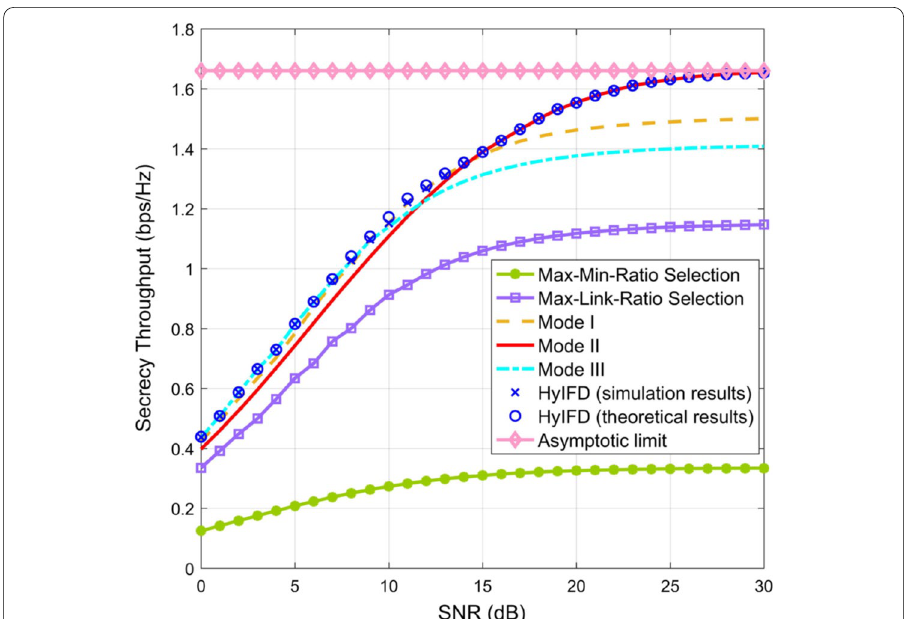
Fig. 3 The maximum secrecy throughput versus SNR for different relaying